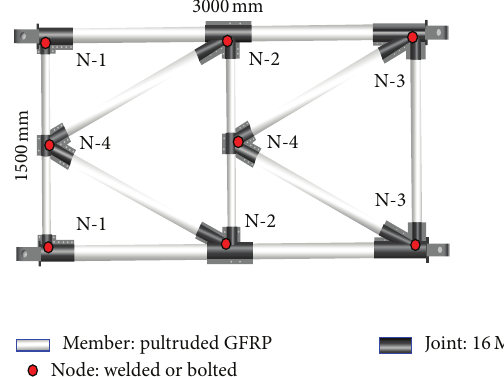
Figure 3: Structural design of the GFRP-steel combined truss.